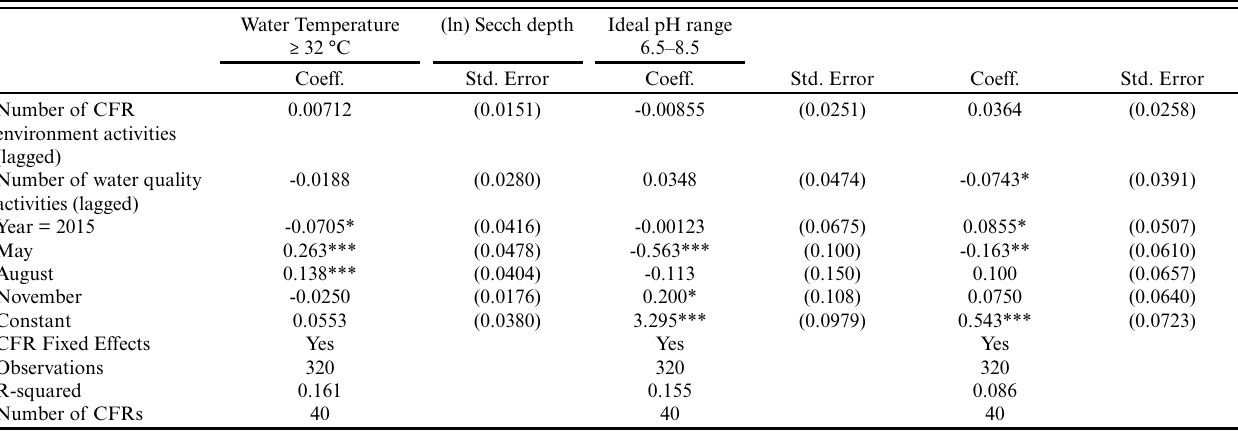
Table 3 . Relationship between community fish refuge (CFR) water quality indicators and previous year habitat management actions. Using longitudinal regression models that include fixed effects for the CFR, we show relationships between the number of management activities undertaken to improve the CFR environment and water quality in the previous year (“lagged” values below) and the current water quality indicators in CFRs. “ln” refers to the natural